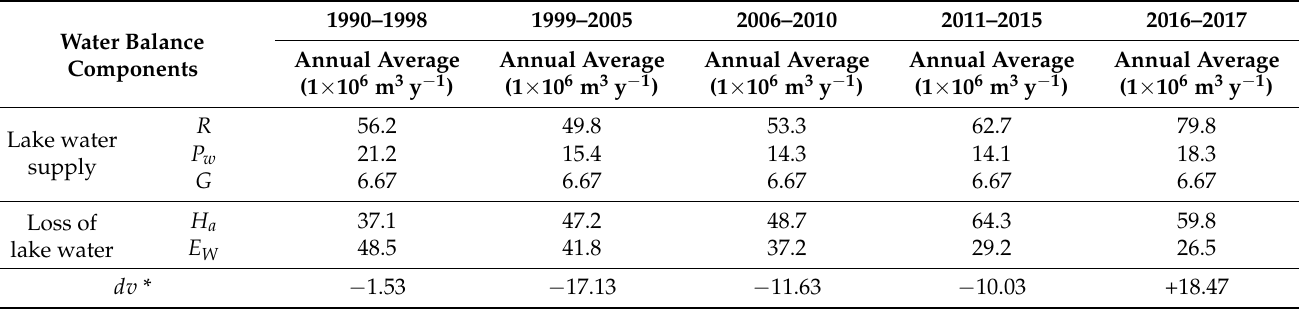
Table 1. The HN water balance from 1990 to 2017.